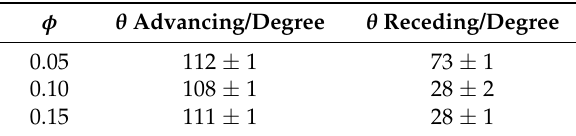
Table 3. Dynamic water contact angles as a function of φ